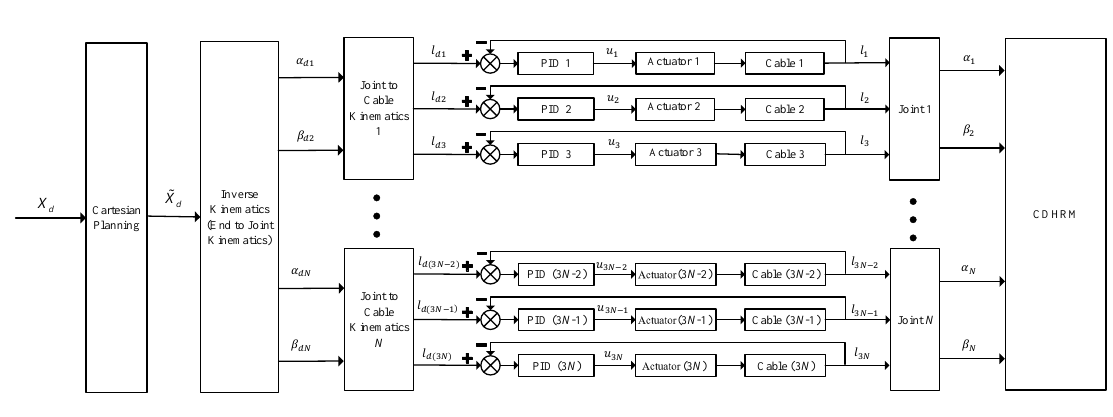
Figure 5. PID-based control scheme of CDHRM.